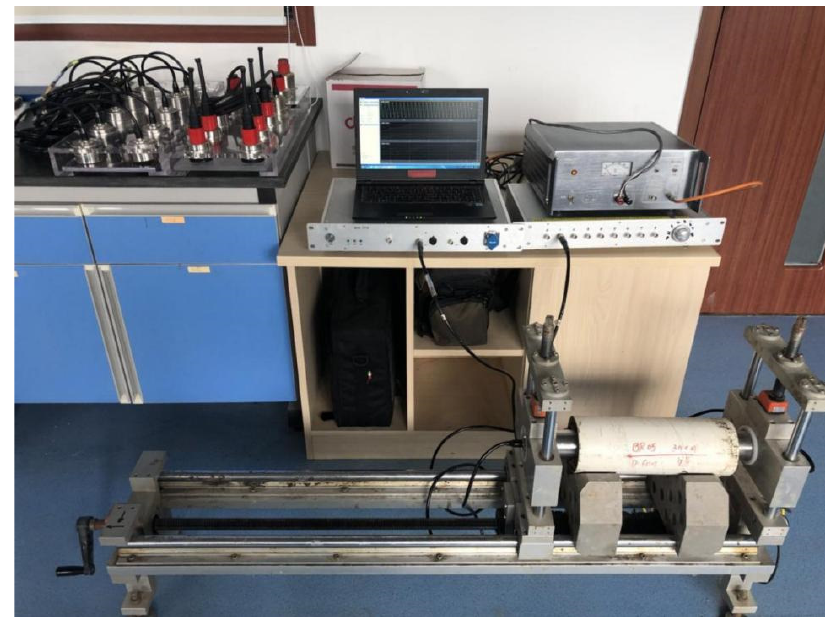
Figure 1. Laboratory measurement system.